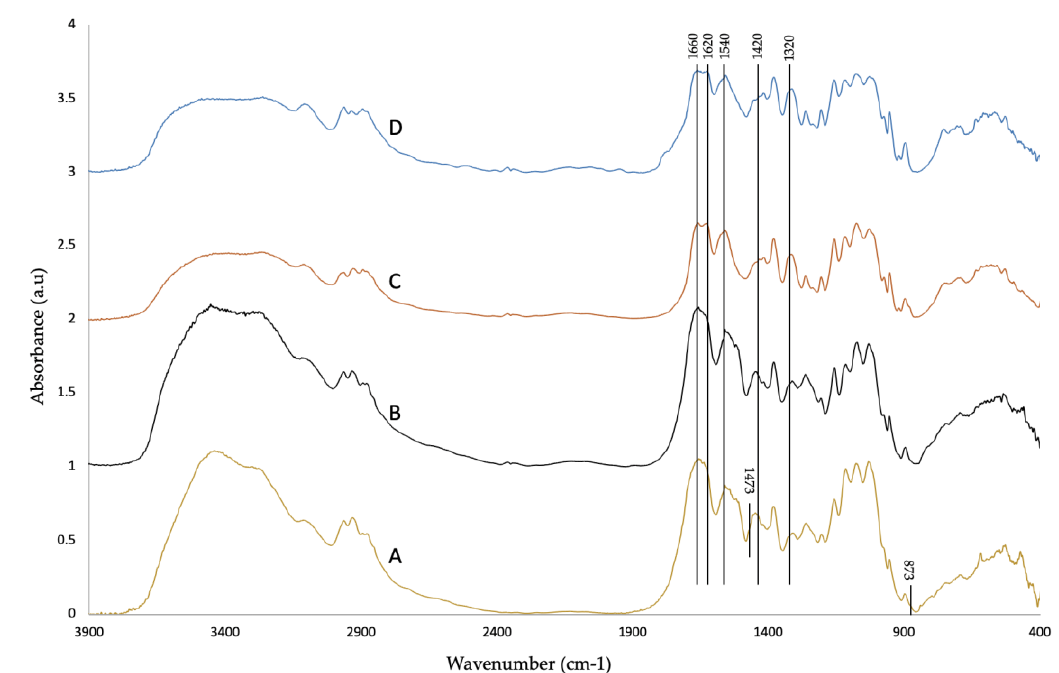
Figure 2. FTIR spectra of ( A ) raw material, ( B ) demineralized, ( C ) deproteinized, and ( D ) decolorized samples. Table 2. Degree of acetylation (DA) and crystallinity index (CrI) of chitin from different sources. Source